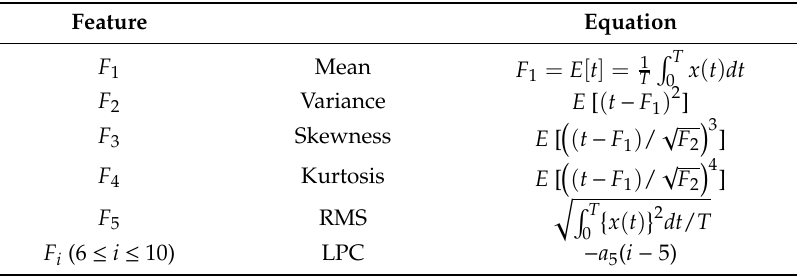
Table 2. Summary of feature parameters. x (t) is defined as x (t) = | s ( t ) | and − a i ( i − 5) are the LPCs of Equation